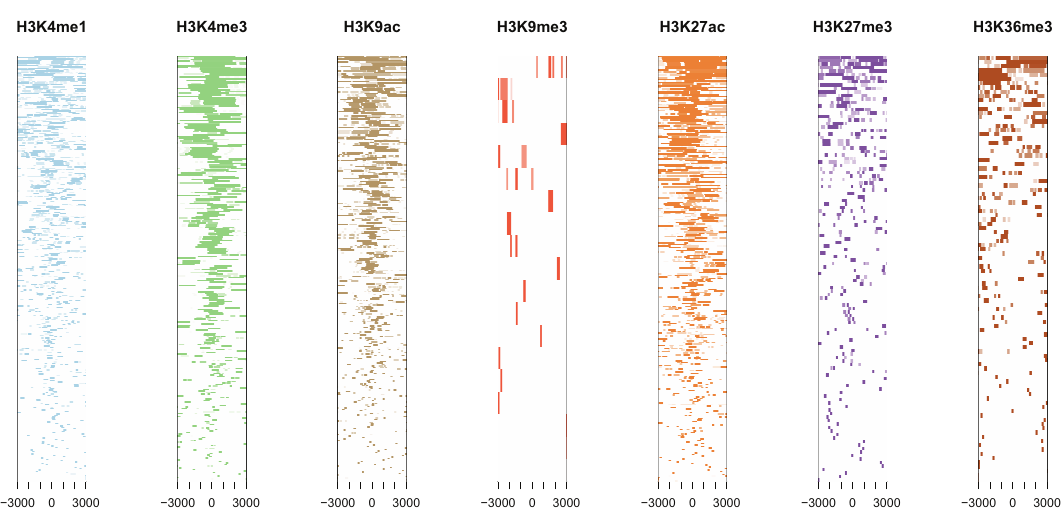
Figure 15. Heatmap of histone marks H3K4me1, H3K4me3, H3K27ac, H3K9ac, H3K9me3, H3K27me3 and H3K36me3 for brain tissues.